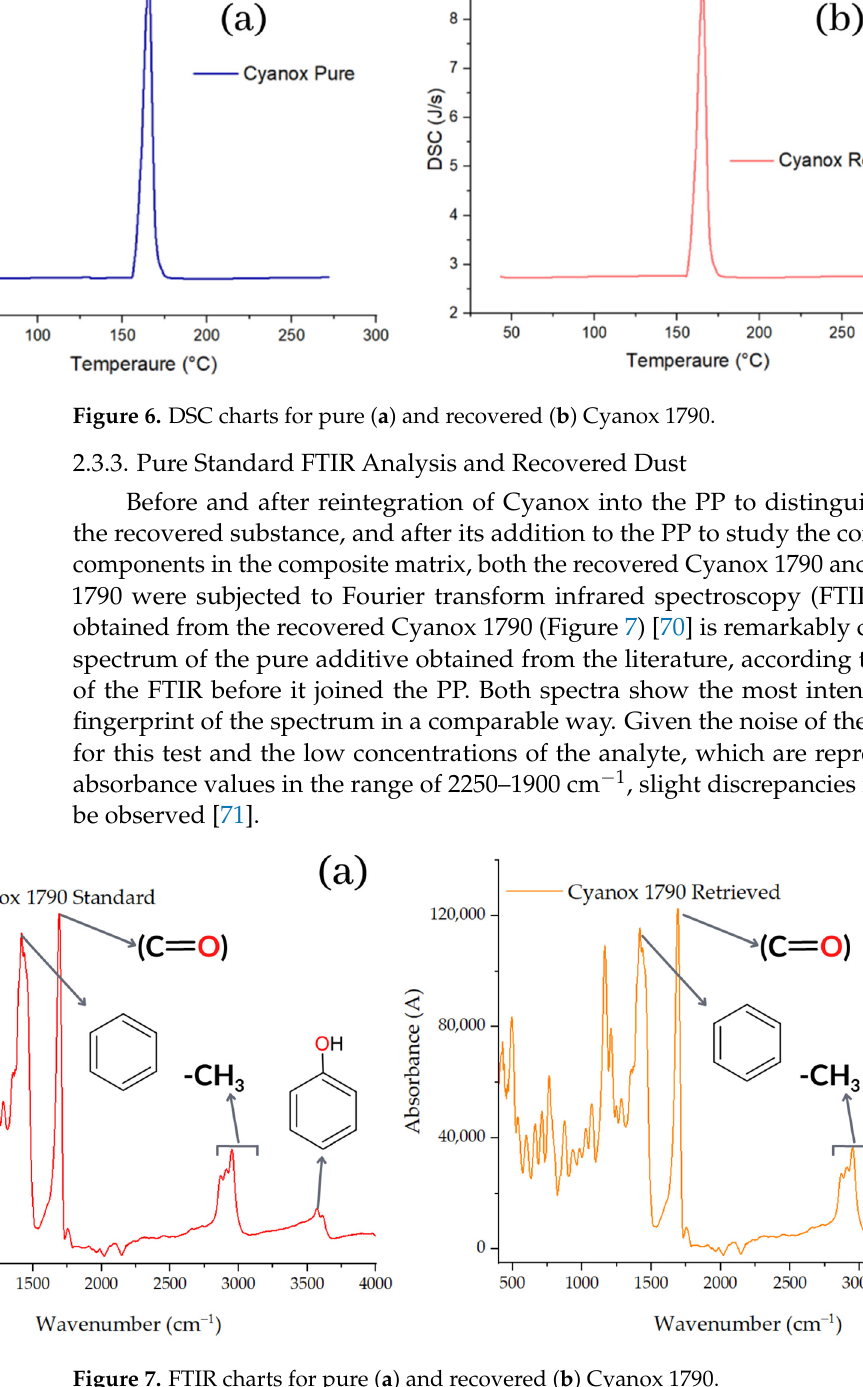
Figure 7. FTIR charts for pure ( a ) and recovered ( b ) Cyanox 1790.